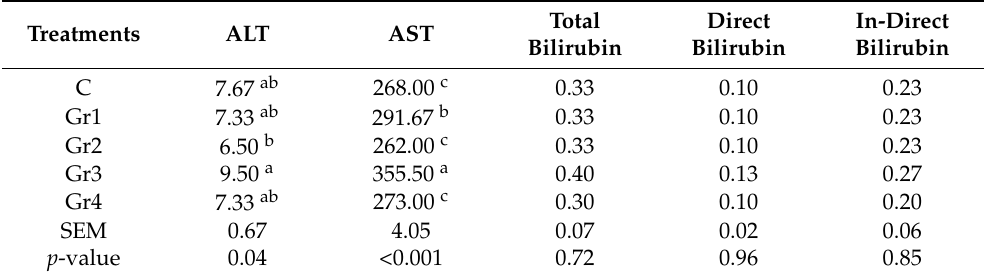
Table 6. Effects of variable concentrations of dietary CP and Lys on the hepatic and renal efficiency of broiler chickens. Treatments ALT AST